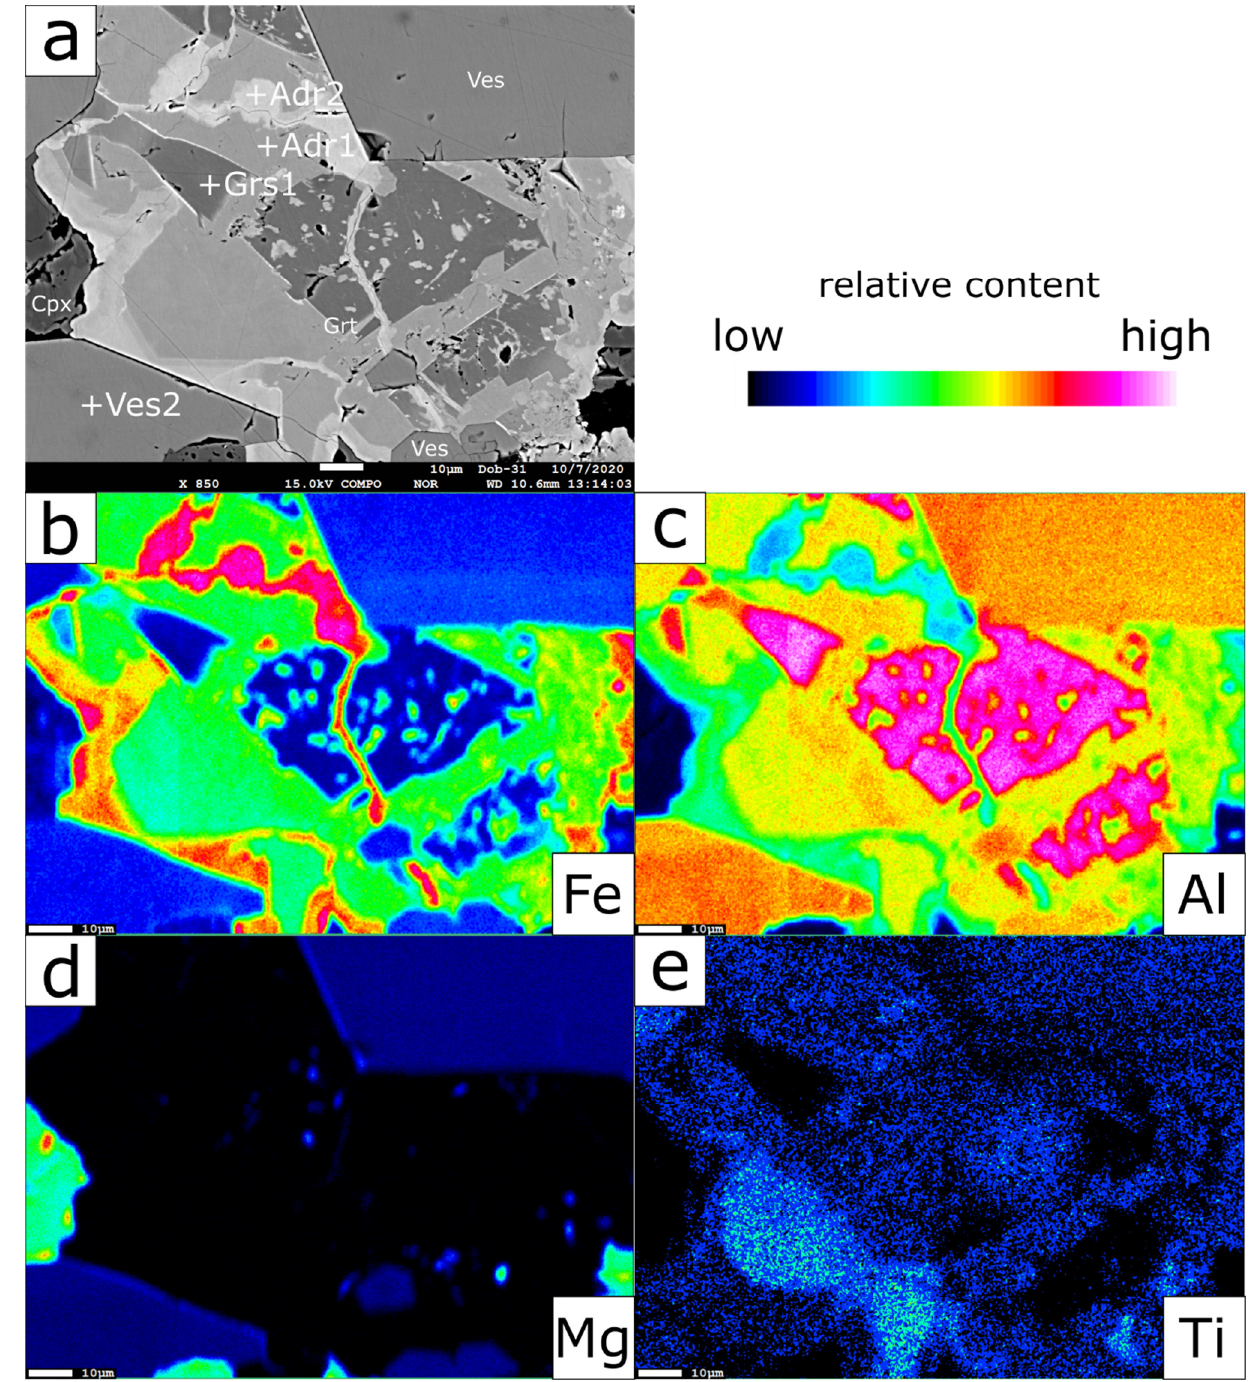
Figure 3. ( a ) BSE (Backscattered electrons) image of the complex garnet solid solution bordered by euhedral vesuvianite. ( b – e ) EMPA element distribution maps of Fe, Al, Mg, Ti, respectively. Ves—vesuvianite; Grt—garnet; Adr—andradite; Grs—grossular; Cpx—clinopyroxene. “+” symbol denotes the exact spot analyzed by EMPA (presented in Tables 1 and 2).